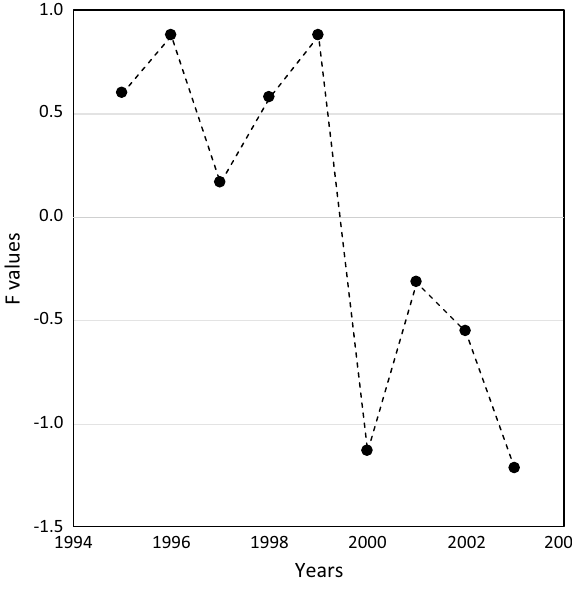
Fig. 1 Evaluation values of NSC in the Fuyang district between 1995 and 2003 using F